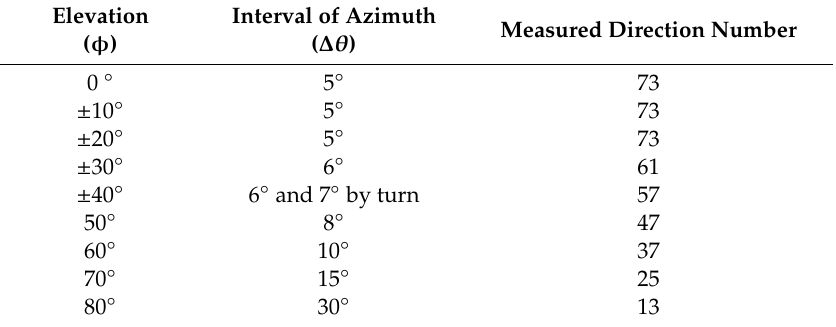
Table 1. Measurement resolution of the used